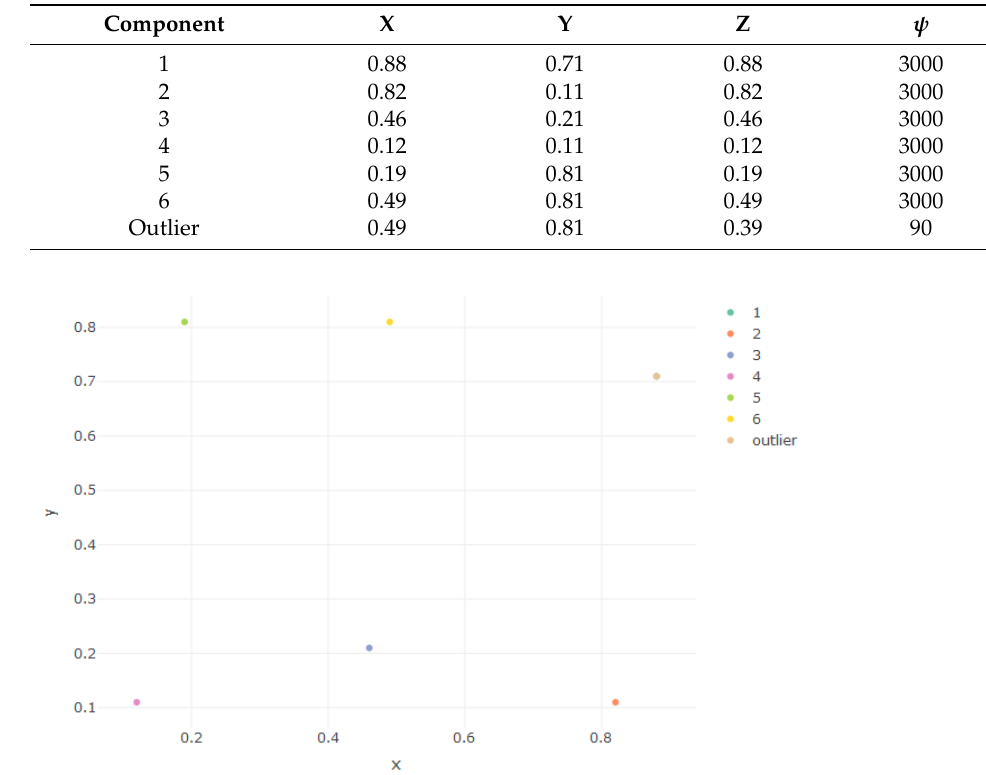
Figure 1. Mean vector of each component, in x, y